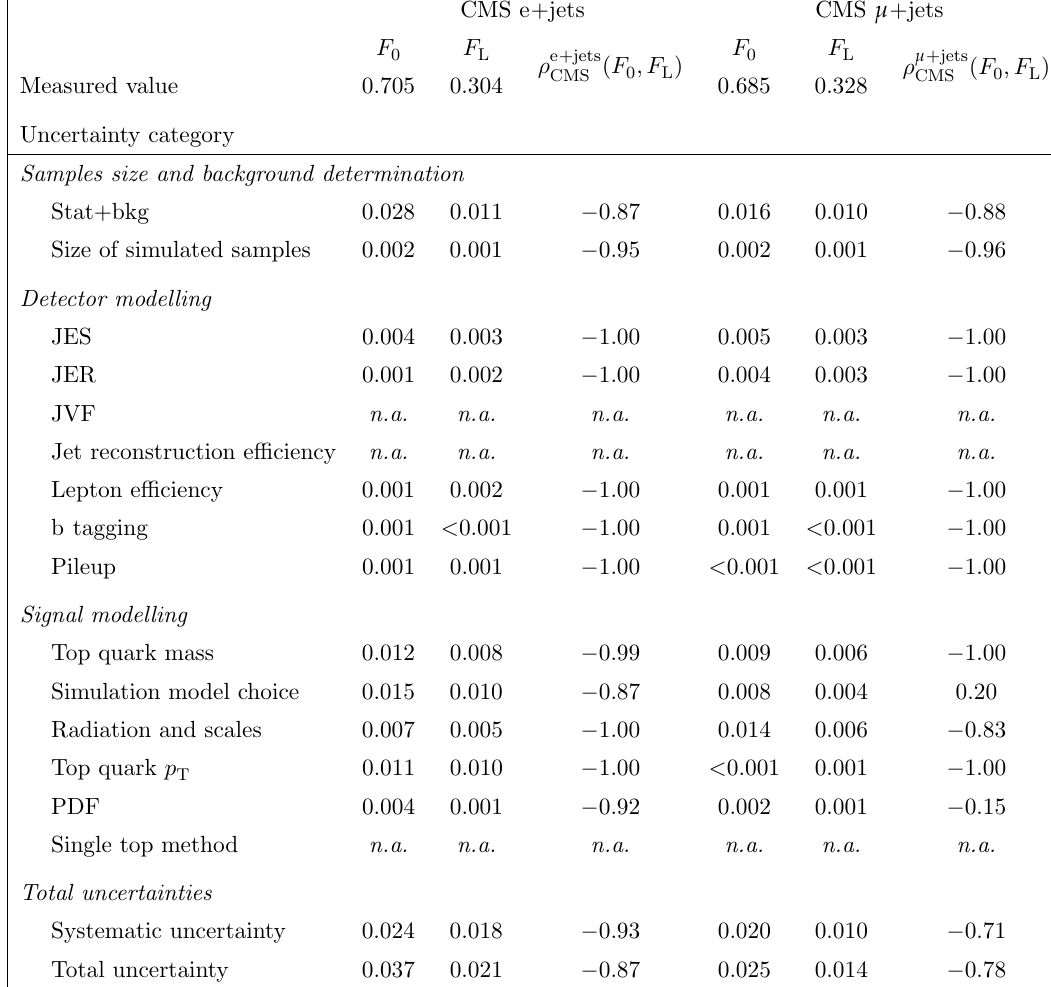
Table 3 . Uncertainties in F , F and their corresponding correlations from the CMS e+jets and 0 L m +jets measurements. The uncertainty that is not applicable to this measurement, or which is included in other categories, is indicated by \ n.a. ". The line \Systematic uncertainty" represents the quadratic sum of all the systematic uncertainty sources except for the uncertainties in the background determination and the integrated luminosity, which are included in the \Stat+bkg" category. The quoted correlation values are obtained via the procedures described in section